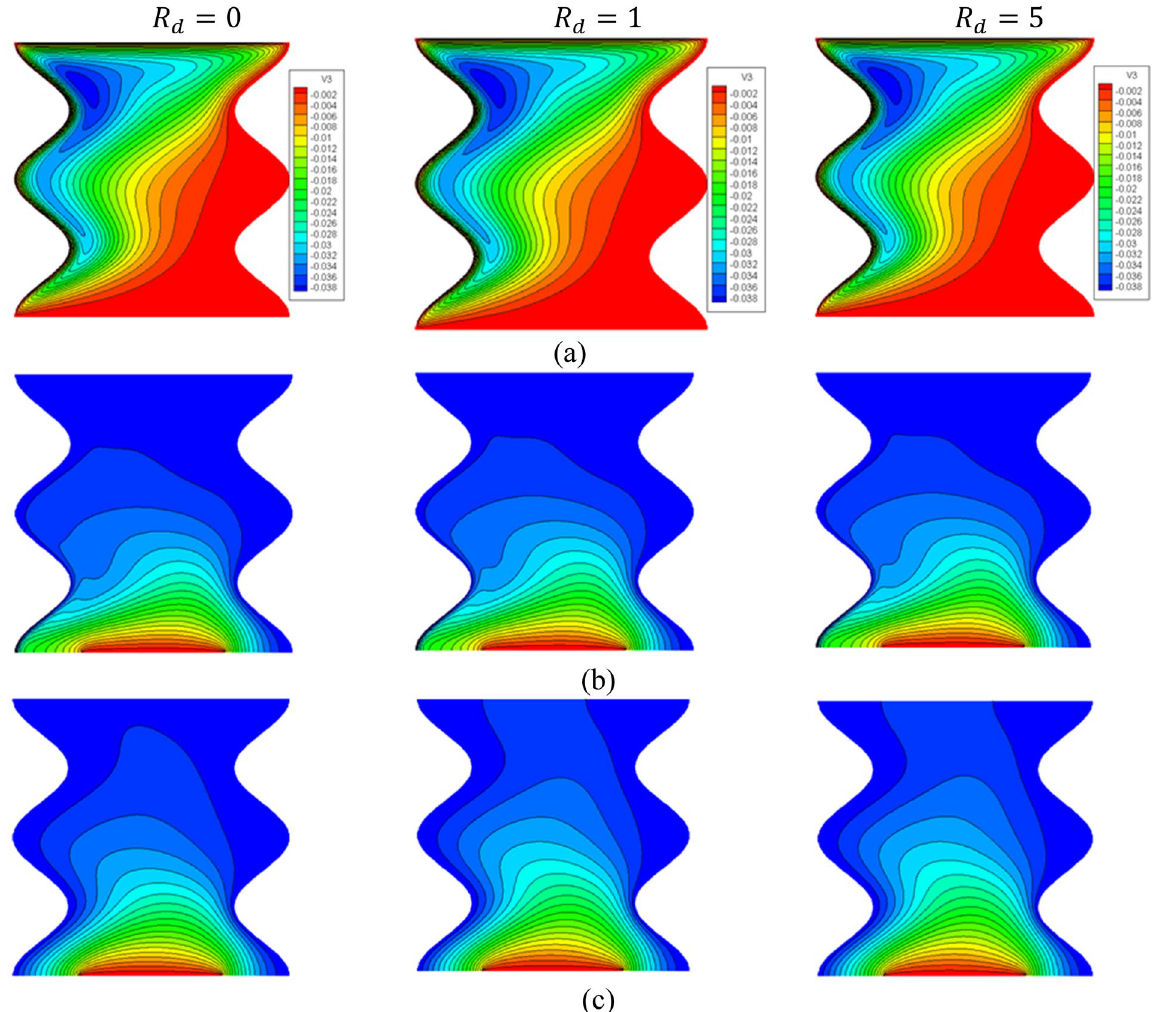
Figure 7. Contours of ( a ) streamlines, ( b ) isotherms of a fluid phase, and ( c ) isotherms of a solid phase below the changes on thermal radiation parameter R d for a hybrid nanofluid at φ Cu